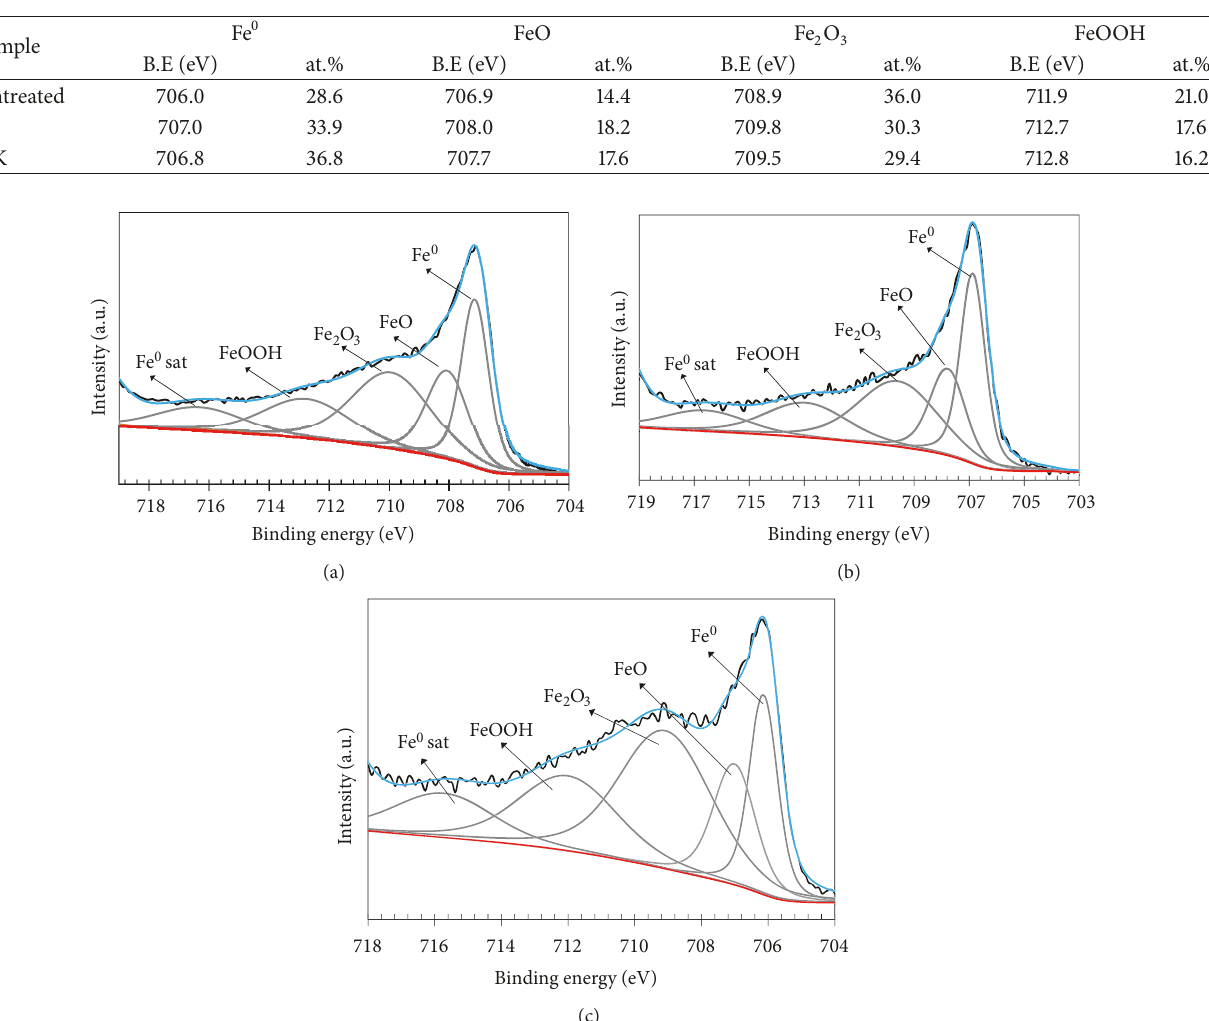
Table 4: XPS fitting results for the Fe2p 3/2 core level.